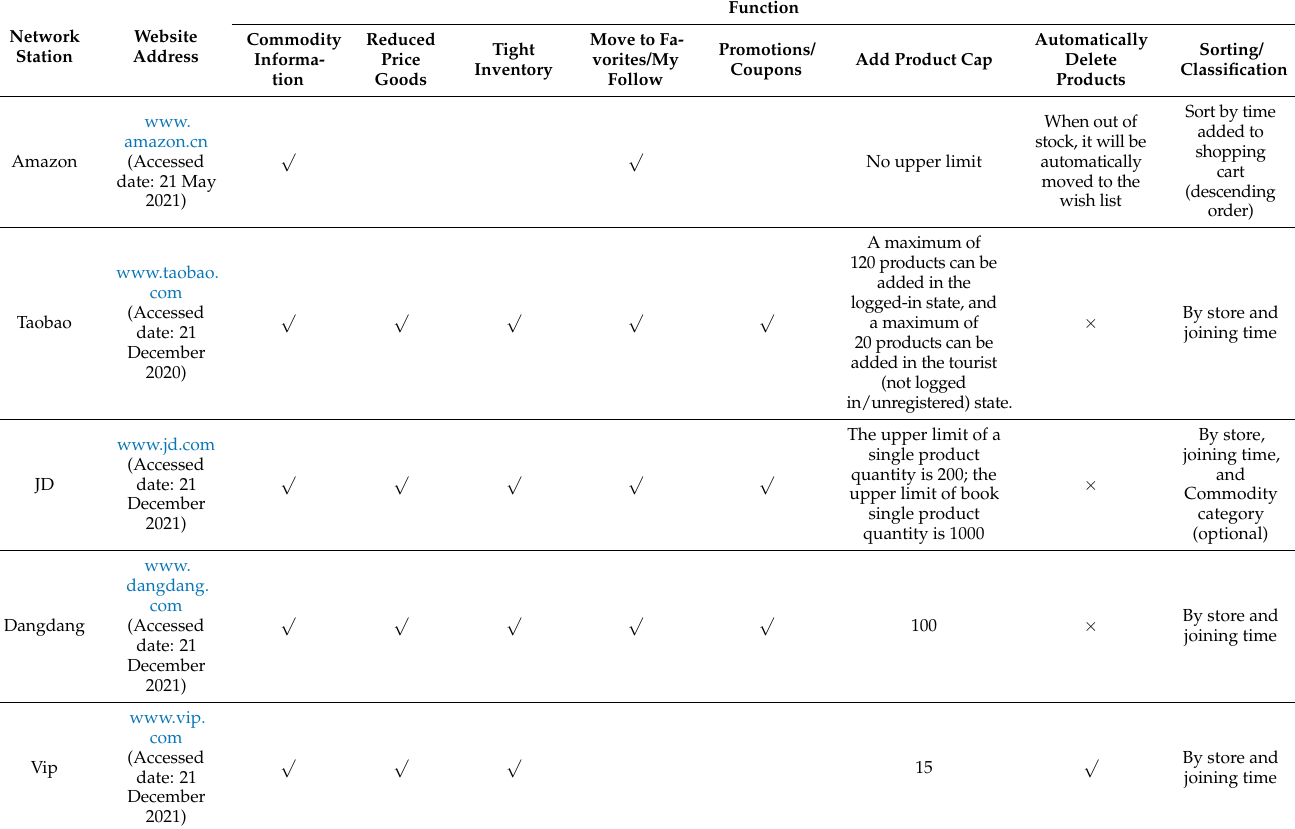
Table 1. Comparison of shopping cart functions on mainstream Chinese